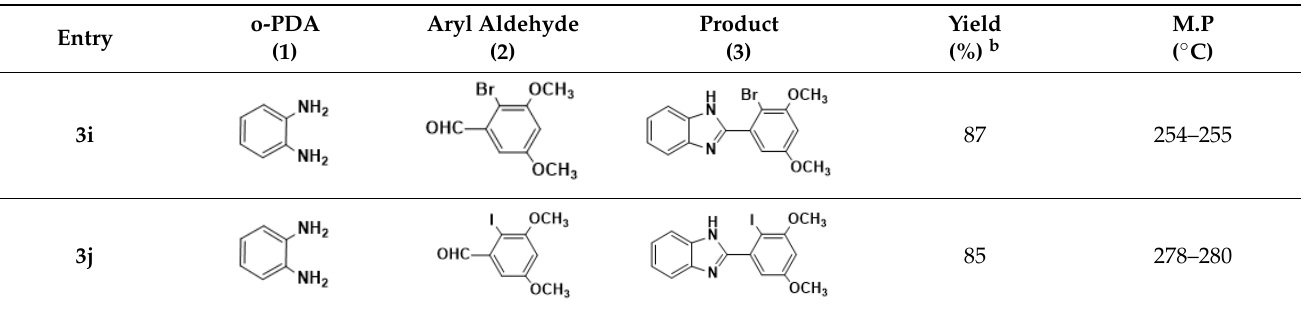
Table 4. Nano ZrO 2 catalysed synthysis of 2-aryl benzimidazoles a .